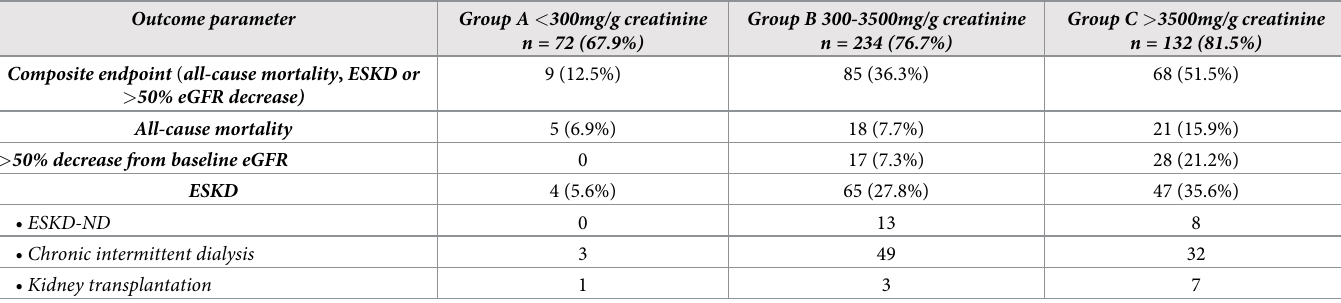
Table 2. Patient outcomes by proteinuria-defined subgroup.